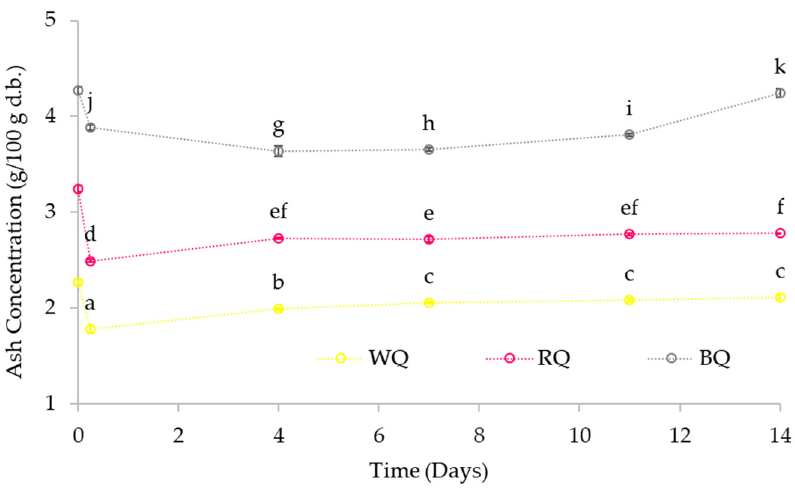
Figure 2. Ash content variation for white (WQ), red (RQ), and black (BQ) quinoa during soaking (0.25 days), germination (4 and 7 days at 20 °C and 100% RH), and refrigerated storage (11 and 14 days at 4 °C and 75% RH). Error bars indicate standard deviation ( n = 3). Results with different letters are significantly different at p ≤ 0.05.